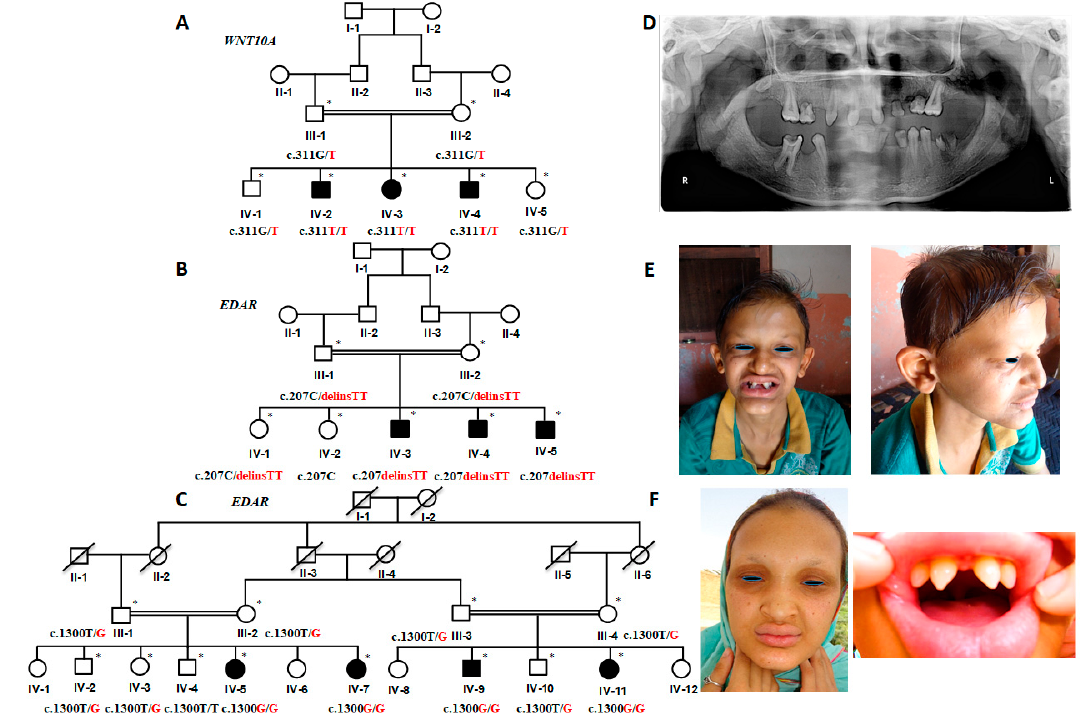
Figure 1. ( A – C ) Pedigrees of family A, B, and C show the autosomal recessive mode of inheritance. The available samples for the genetic analyses are marked with asterisks (*). The genotypes of each participant in these pedigrees are mentioned below the symbols, showing the segregation of the alleles. The black color represents the wild-type allele and red color depicts the disease-allele ( D ) Orthopantomogram (OPG) of the a ff ected member (IV-2), family A, revealed the absence of the majority of permanent teeth, except maxillary first molars, maxillary central incisors, maxillary right canine, and mandibular left first and second premolars and mandibular right first premolar (teeth # 16, 26, 11, 21, 13, 34, 35 and 44, respectively, according to FDI nomenclature). ( E , F ) A male patient (IV-3) of family B and a female patient (IV-5) of family C are showing pigmentation around lips and eyes, sparse scalp hair, eye-brows, and eye-lashes, saddle-shaped nose, and characteristic canonical